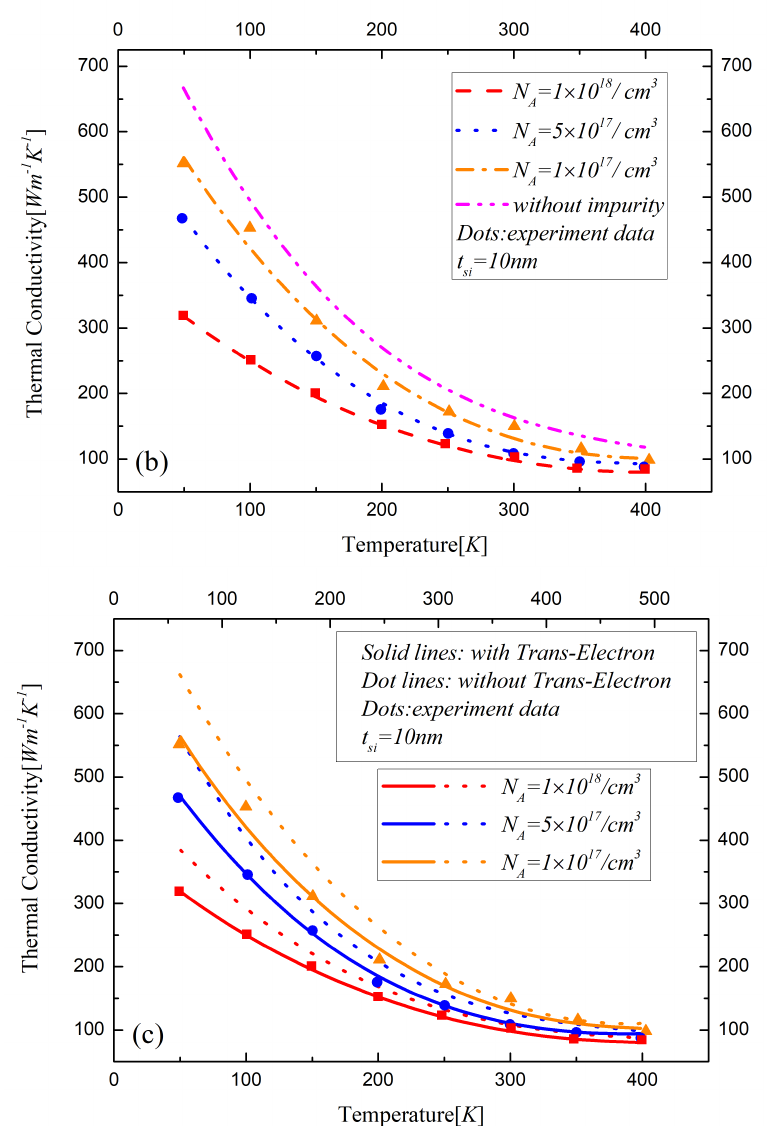
Figure 4. The influences of ( a ) boundary scattering effects, ( b ) impurity, ( c ) free and bound electron on the thermal conductivity of the 10 nm-thickness silicon film material in ultra-thin body FD-SOI